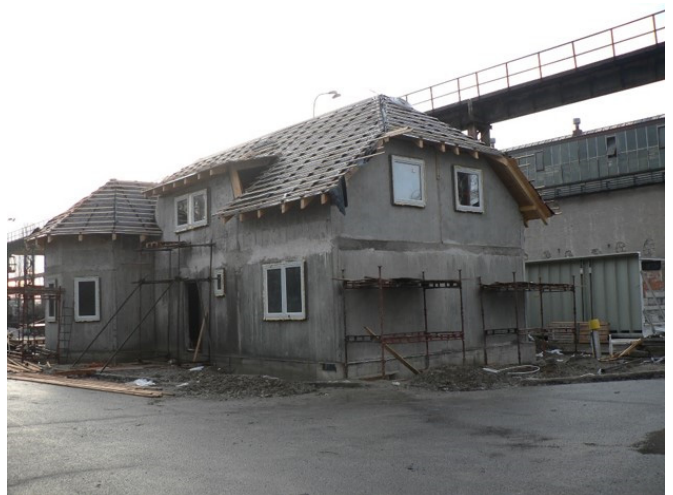
Figure 1. A view of the construction of the prototype prefabricated house IDA I [1].